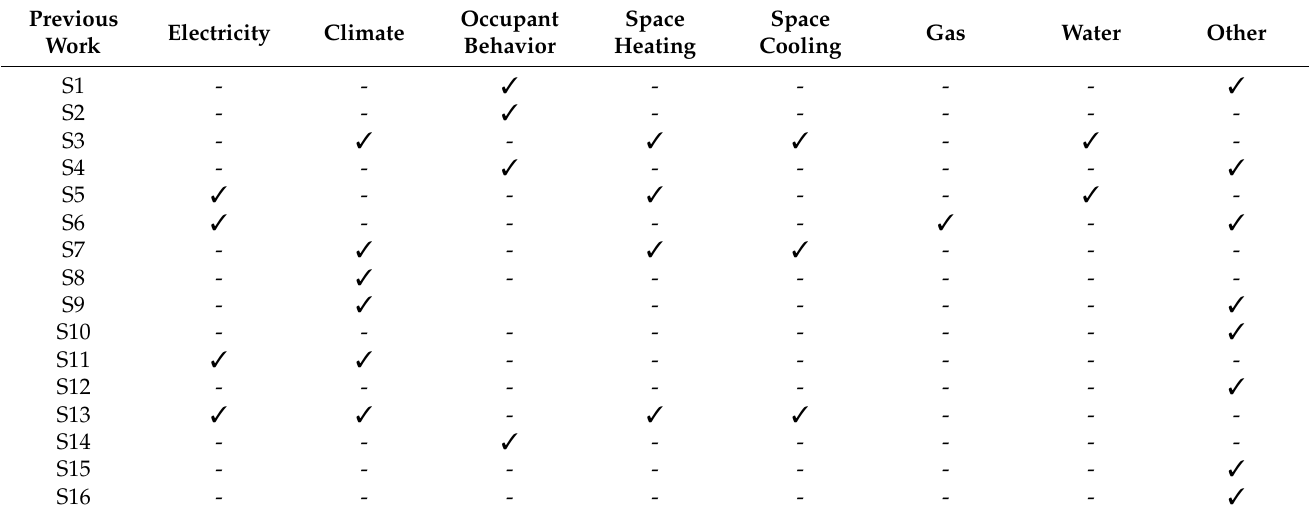
Table A1. Major factors of energy consumption of